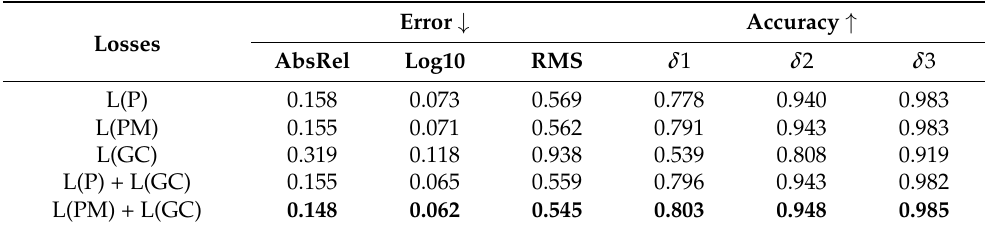
Table 3. Ablation study of PoseNet